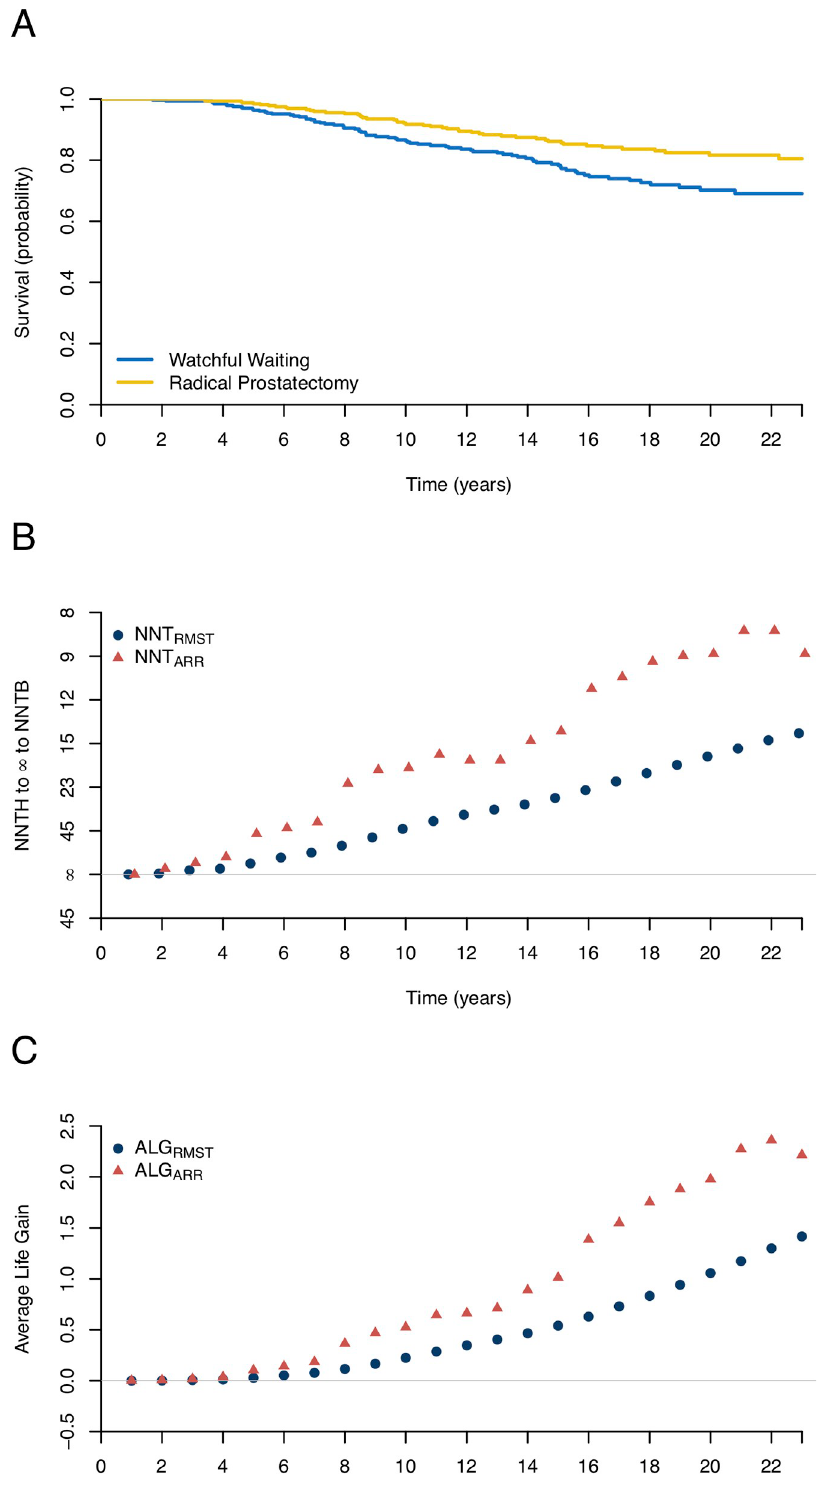
Fig 1. Estimated survival curves, numbers needed to treat (NNTs), and the average life gain (ALG) based on the reconstructed data from the radical prostatectomy study. (A) Kaplan-Meier curves for the radical prostatectomy